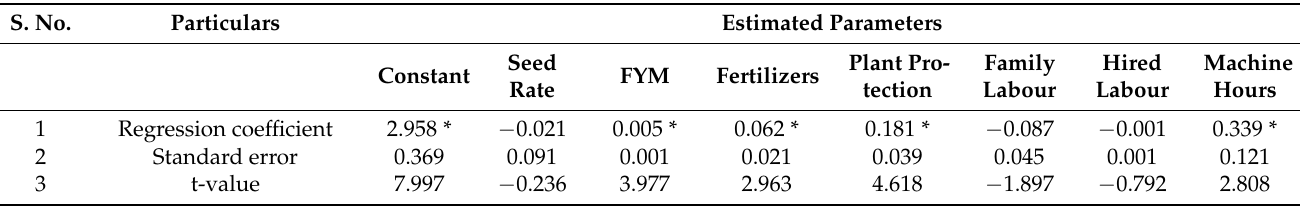
Table 6. Production function estimates of marigold cultivation in Jammu